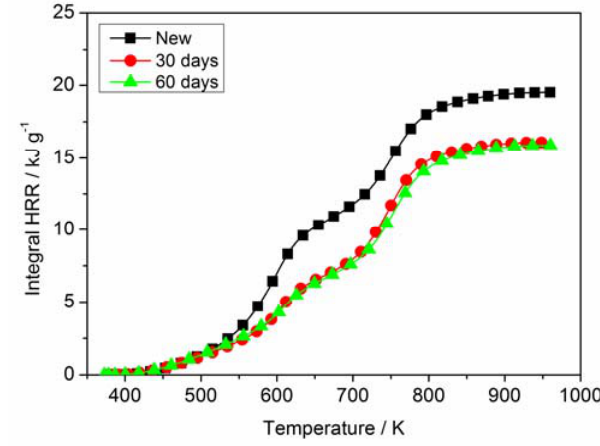
Figure 8. Integral HRR (total heat release (THR)) of PVC sheaths for new and aged cables. Table 4. MCC data of new and aged cable sheaths.